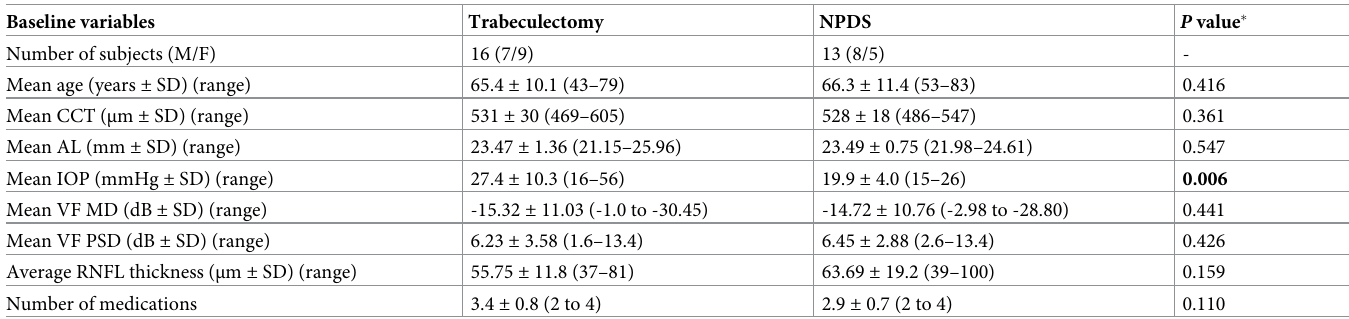
Table 1. Baseline